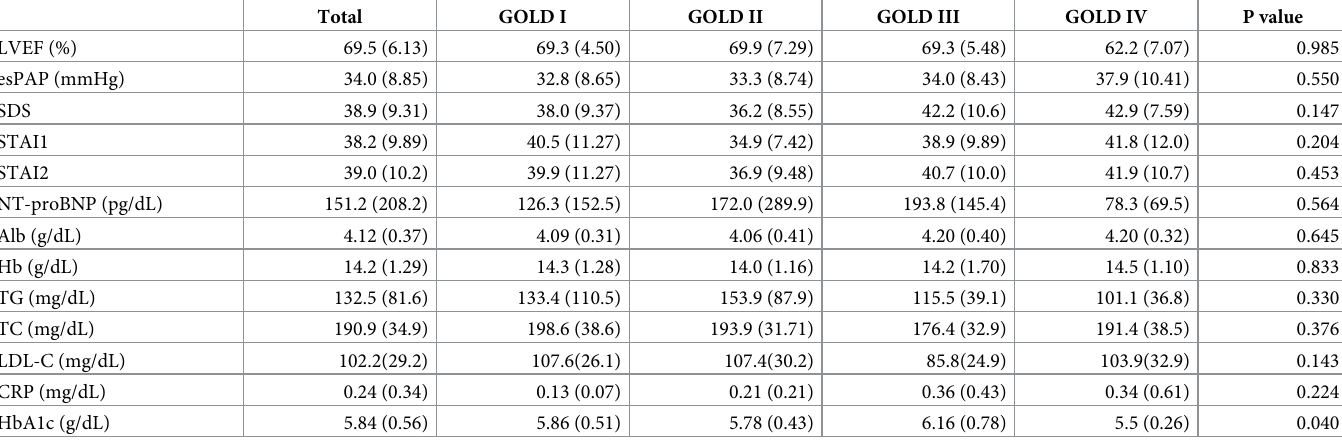
Table 2. Mean values of the parameters of extrapulmonary comorbidities by GOLD stages.